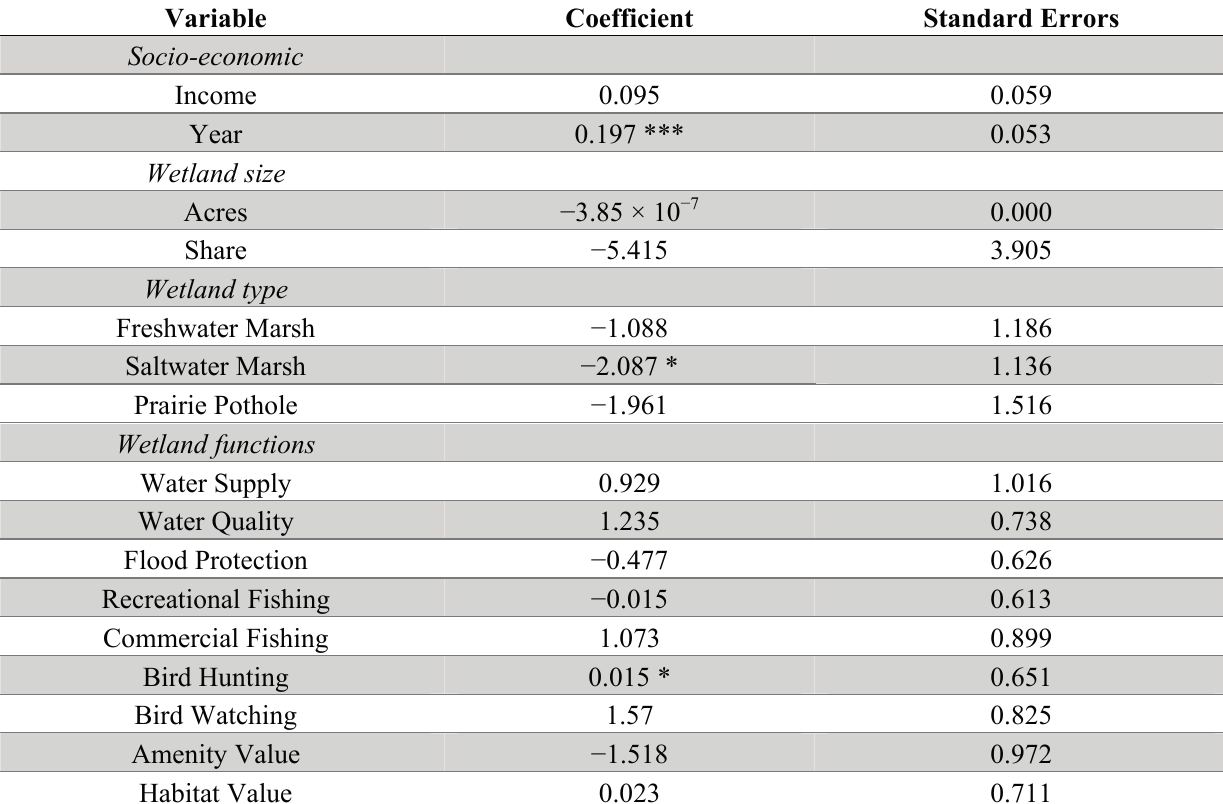
Table A1. Description of variables and regression coefficients from meta-analysis of wetland value per acre estimates conducted by